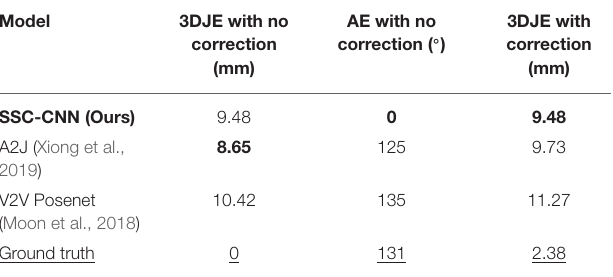
TABLE 2 | 3D Joint Errors (3DJE) and Anatomical Errors (AE) derived from 40,000 images from the HANDS2017 dataset with all the